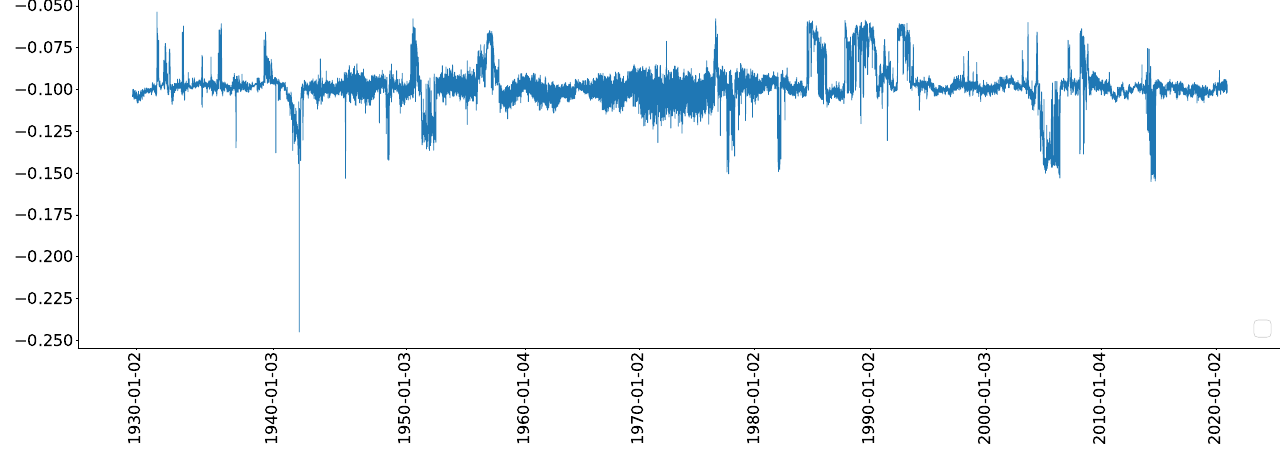
Figure 15. A relative difference between CoCVaR and CoVaR plot for α = β = 0.01.